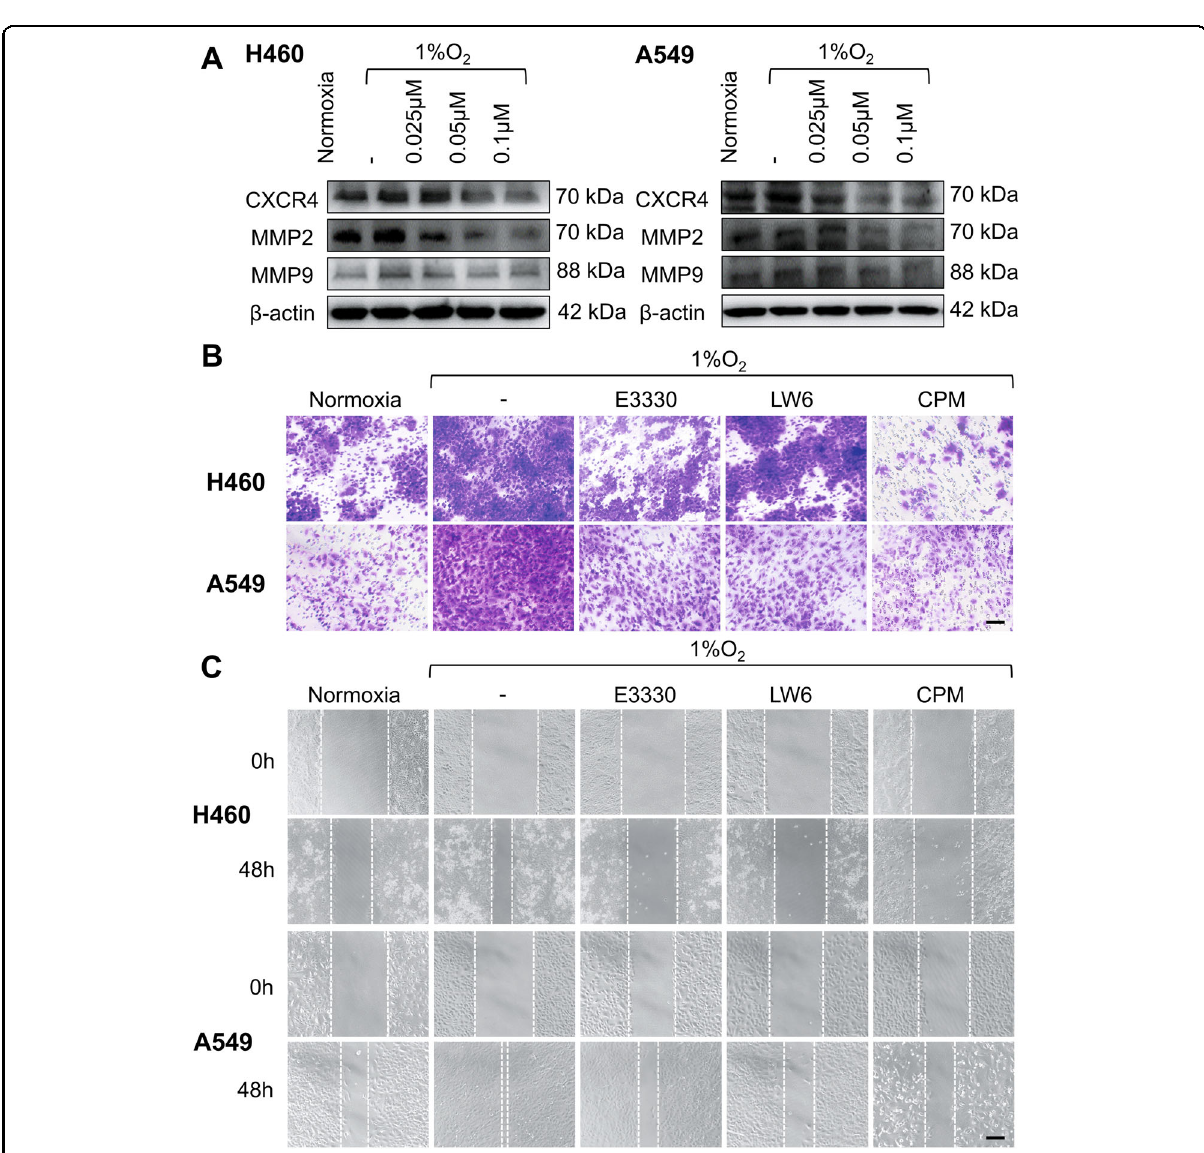
Fig. 5 Inhibitory effect of CPM on migration in LC cells. A CXCR4, MMP2, and MMP9 expression was analyzed in hypoxic-exposed H460 and A549 cells and treated with CPM at various concentrations. B Hypoxia-induced migration in H460 and A549 cells was examined by transwell assay. H460 and A549 cells were cultured in the upper partition of a transwell chamber exposed to 1% O 2 , and treated with APEX1 inhibitor E3330, HIF-1 α inhibitor LW6 and CPM. Scale bar, 50 μ m. C Wound healing assay was performed to test the effect of CPM on cell migration. H460 and A549 cells were incubated with E3330, LW6, and CPM, and exposed to 1% O 2 for 48 h. Scale bar, 100 μ m. The results shown were representative of three independent